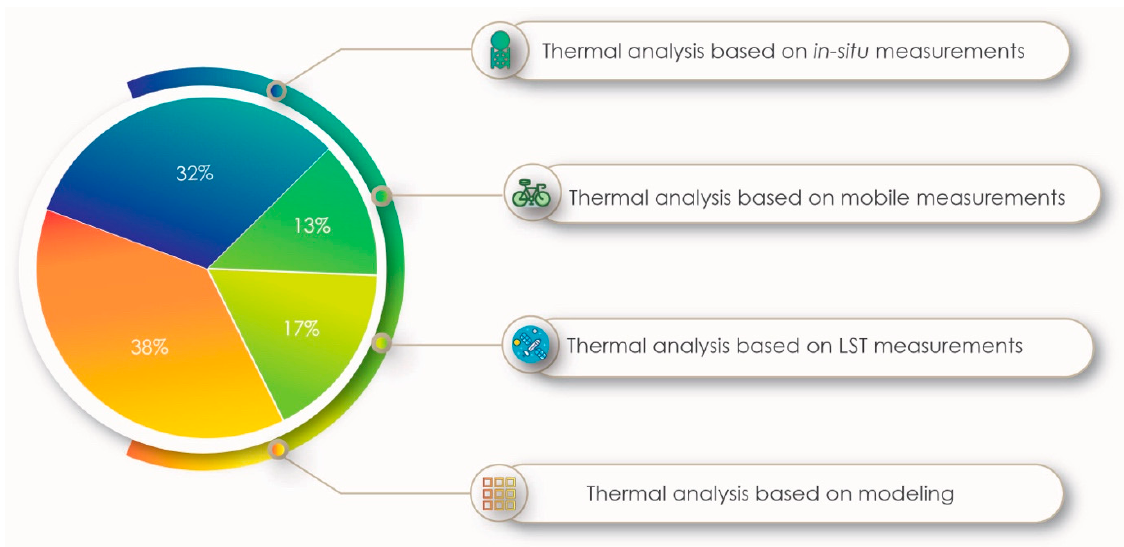
Figure 9. Distribution of the studies reviewed, arranged by type of dataset/analysis used for the thermal patterns of LCZs. Note: Only the articles focusing on thermal analysis are included in the chart (66 studies in total).